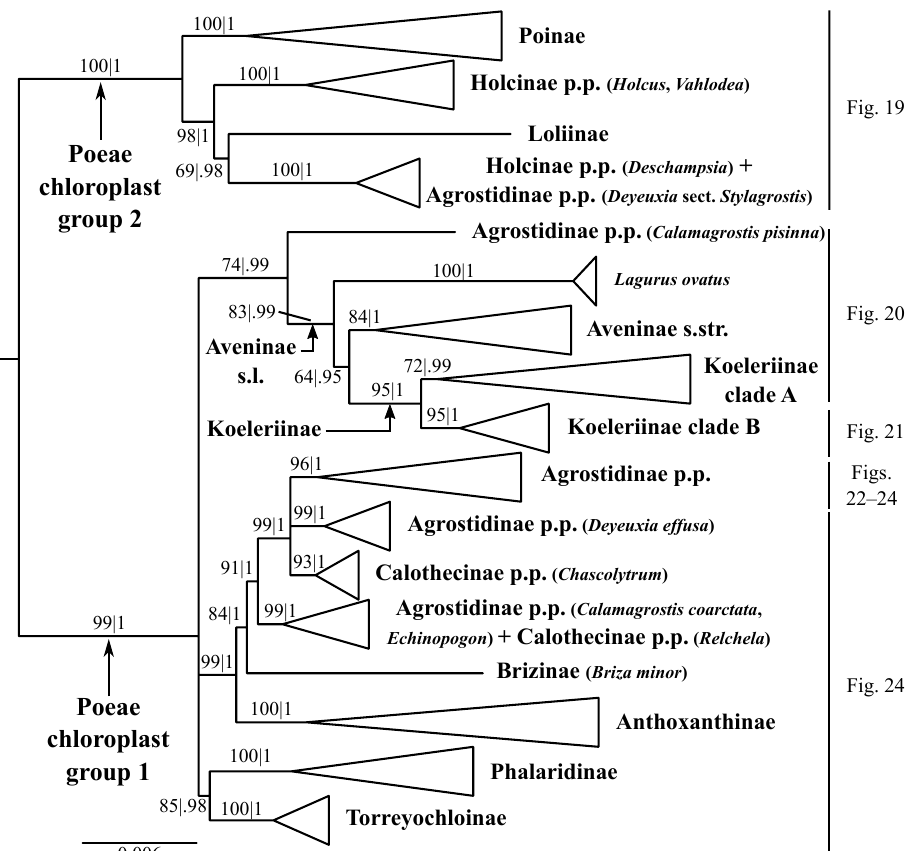
Figure 3. Overview of the maximum likelihood phylogram inferred from combined plastid data ( atpF– atpH , psbK–psbI , psbA–rps19–trnH , matK , trnL–trnF ). Major clades in the complete tree are collapsed. The corresponding figures showing details of subsections of the tree are indicated. ML bootstrap support (left) and BI poster probabilities (right) are recorded along branches. No support is shown for branches with bootstrap support <50% and posterior probability <.5. The ML tree is presented in its entirety in Suppl. material